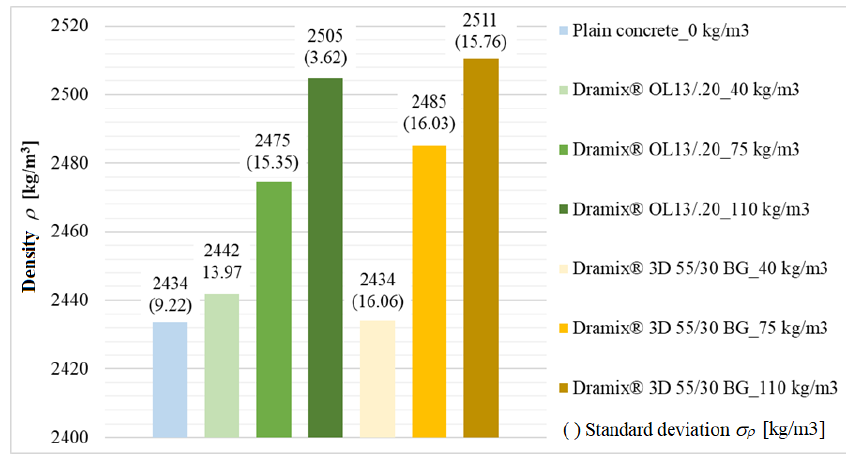
Figure 6. The average densities of plain concrete and fiber-reinforced concrete.